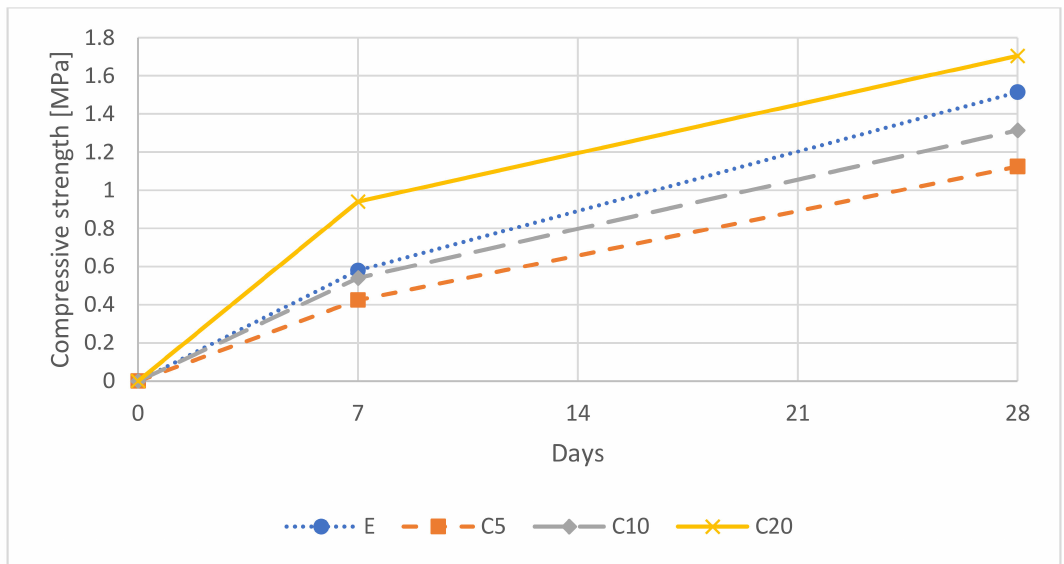
Figure 2. Development of compressive strength from 7–28 days in Series 1 (same w/b ratio, different percentage of WPC).